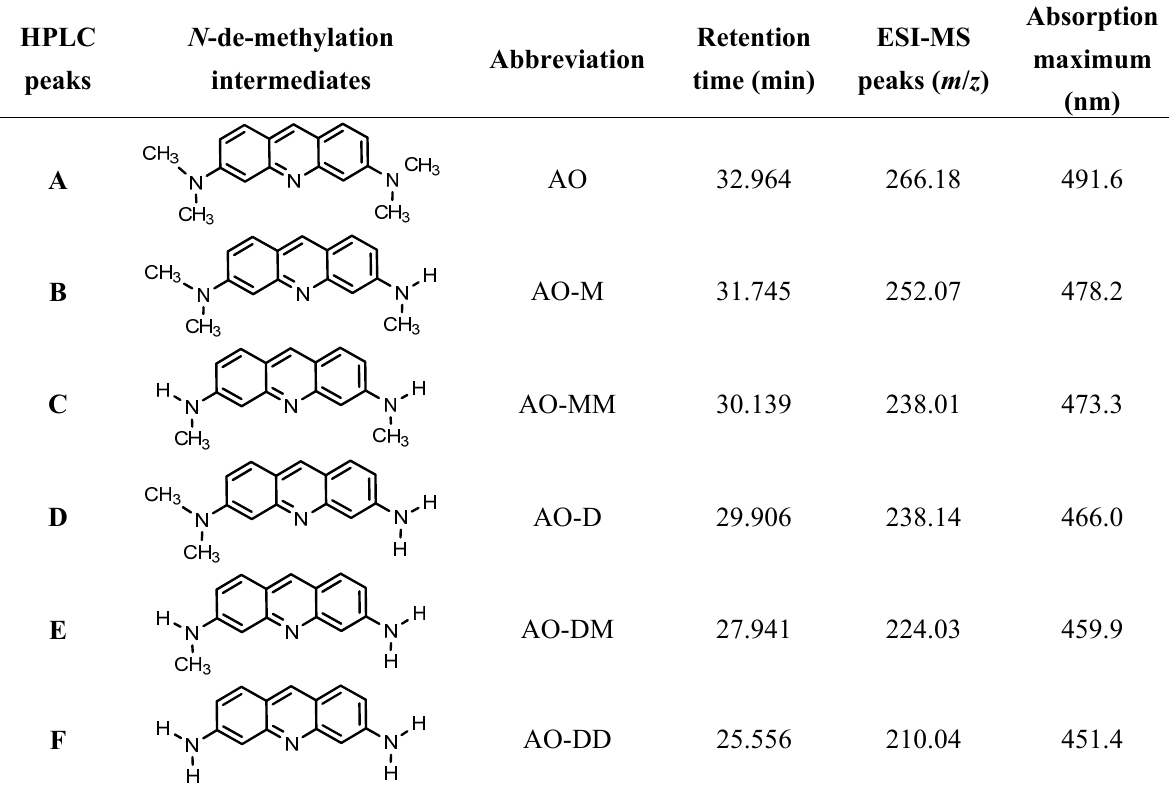
1. Identification of the N -de-methylation intermediates of the AO dye by